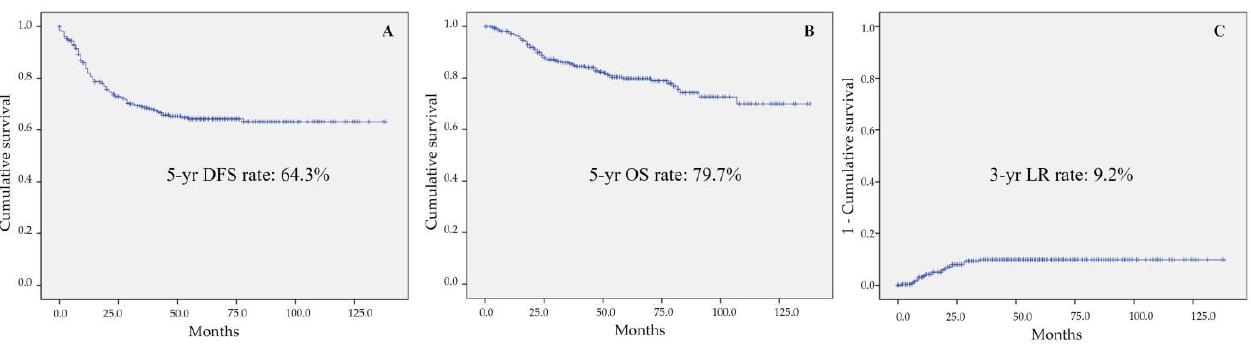
Figure 2. Cumulative survival of all enrolled patients: ( A ) 5-year disease free survival (DFS) rate, ( B ) overall survival (OS) rate, and ( C ) 3-year local recurrence (LR) rate. Table 5. The results of oncologic outcomes according to various factors through the univariate